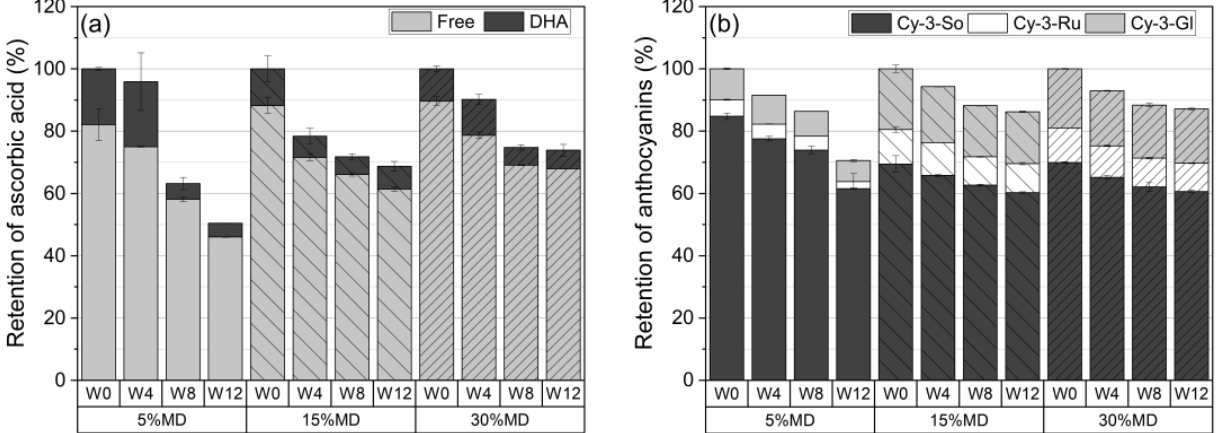
Figure 3. Percentage retention of ( a ) ascorbic acid and ( b ) anthocyanins in dried raspberry foams containing 5% ( w / w ) PP + 2.5% ( w / w ) P at various MD concentrations. (Free: free ascorbic acid; DHA: dehydroascorbic acid, Cy-3-So: cyanidin-3-sophoroside; Cy-3-Ru: cyanidin-3-rutinoside; Cy-3-Gl: cyanidin-3-glucoside; W: week).